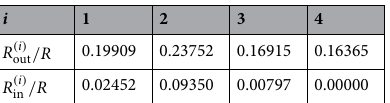
Table 1. Optimized radii of the rubber-lead rods.